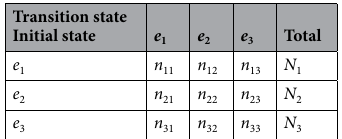
Table 1. Sample number of state